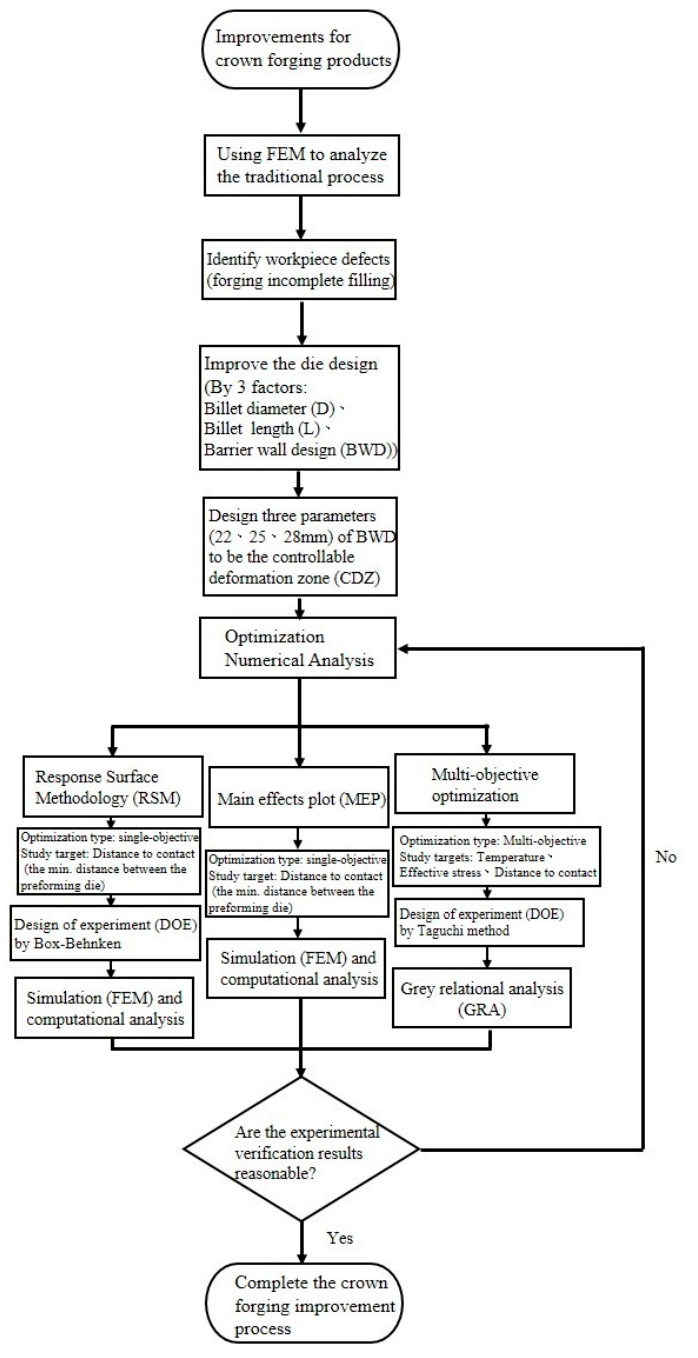
Figure 4. Flow chart of experimental design for workpiece optimization in this research.